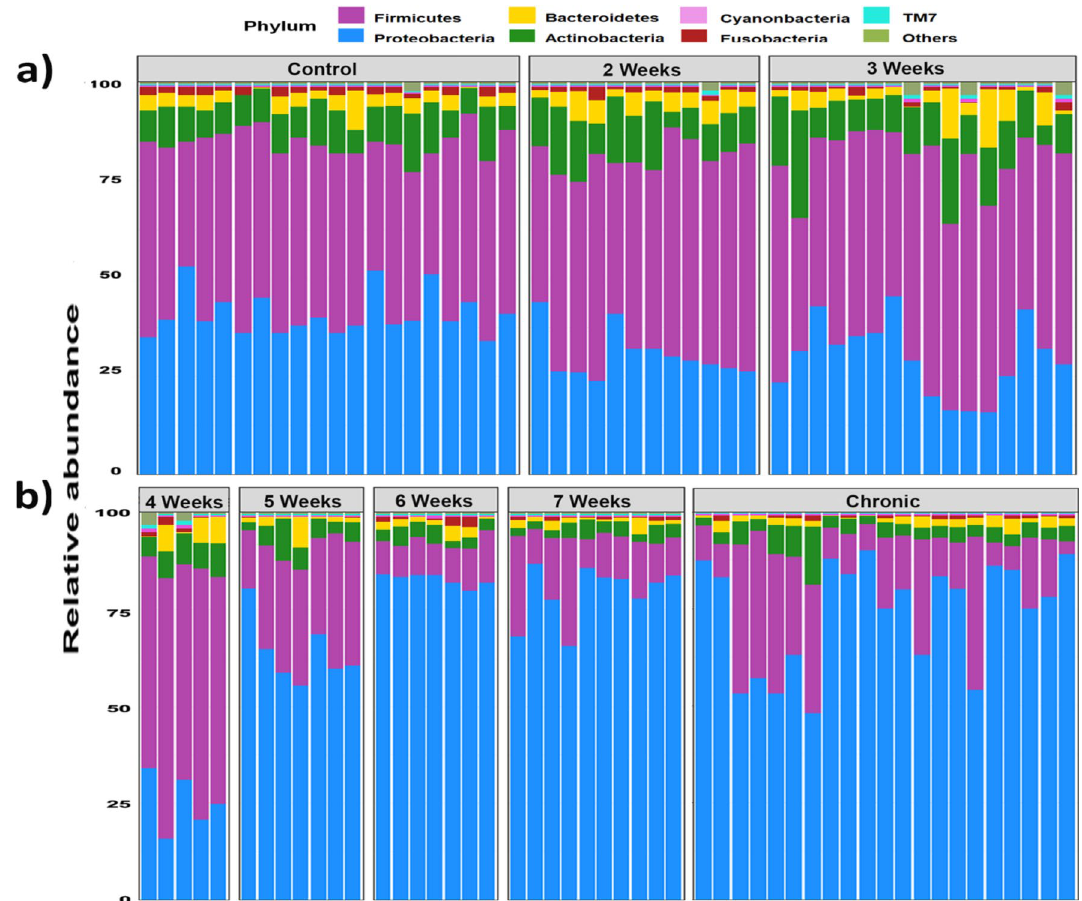
Figure 1. Phylum level analysis of cutaneous microbiota. Bar charts illustrate the relative proportions of the dominant phyla in skin microbiome of all studied groups. ( a ) Cutaneous microbiomes of rapidly recovered RID. ( b ) Cutaneous microbiomes of RID that showed delayed healing or turned to chronic ulcer. X-axis denotes the microbiome profile of each enrolled subjects, while Y-axis indicates the relative abundance of each phyla 37 and low abundance of Firmicutes (Mean relative abundance: 74.01% and 18.36%, respectively; Kruskal Wallis, P = 0.00083).